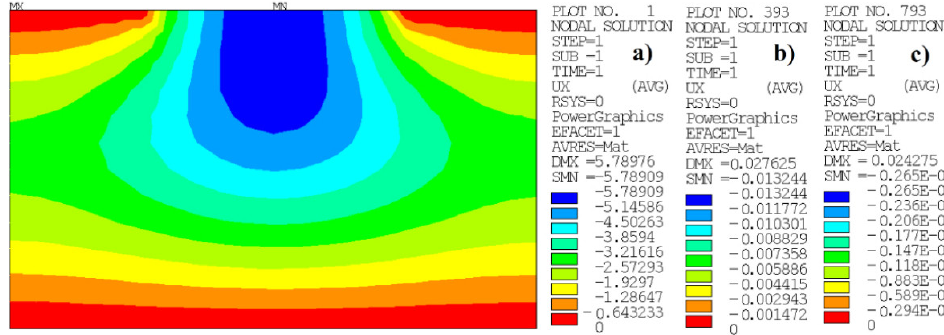
Figure 8. Pore pressure distribution and evolution at ( a ) 4.385, ( b ) 434.115, and ( c ) 872.615 days.